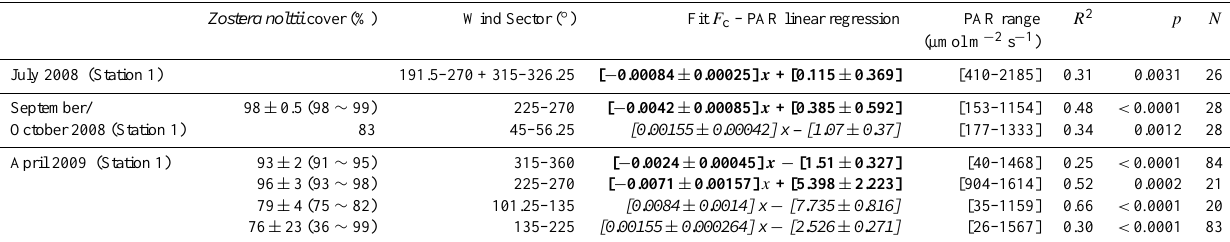
Table 4. F c – PAR relationships obtained at low tide during the day in the Arcachon flat according to wind directions; F c : EC Carbon dioxide fluxes; PAR: photosynthetically active radiation; R 2 : coefficient of determination; p : probability that the slope is significantly non-zero; N : number of values used for each regressions. F c values obtained in July 2008 during the beginning of the experiment (days 183, 184) and in September–October 2008 (day 279) have been discarded representing destocking but not biological degassing by respiration (Figs. 5f and 6f). Only significant linear regressions (p value < 0.01) are presented. Equations in bold and in italic represent negative and positive F c – PAR relationships respectively. Zostera noltii covers for the April 2009 flux data are derived from a SPOT image from ten weeks later (26 June 2009) and are thus probably much higher than during the flux measurements. Zostera noltii cover